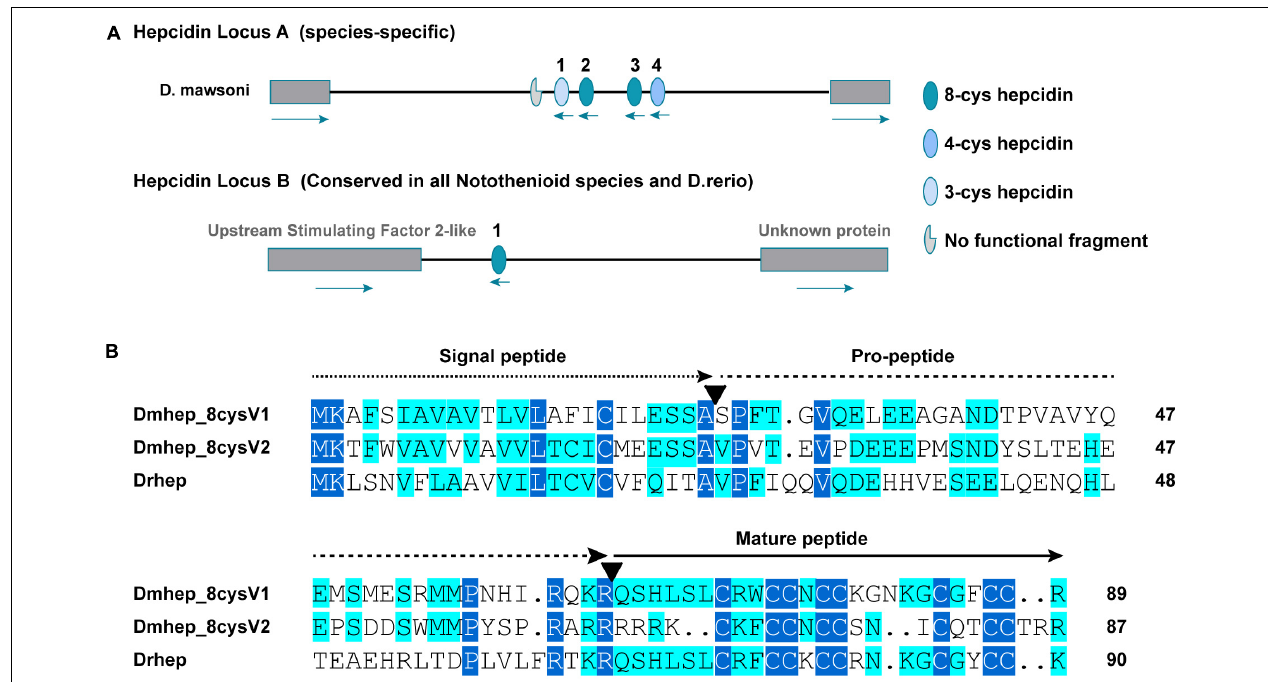
FIGURE 2 | Sequence characteristics of hepcidin variants. (A) The distribution of conserved and non-conserved hepcidin variants in the genome. (B) Multiple amino acid alignment and comparison of the different hepcidin variants from D. mawsoni ( Dmhep_8cysV1 and Dmhep_8cysV2 ) and D. rerio ( Drhep ). The three functional regions of the prepropeptide are represented by different lines at the top of each region. The number of amino acids for each variant is shown at the end of each sequence. The putative cleavage sites of the signal peptide and the mature hepcidin are marked with inverted triangles. Levels of amino acid conservation are highlighted by dark blue (identical) and light blue (two